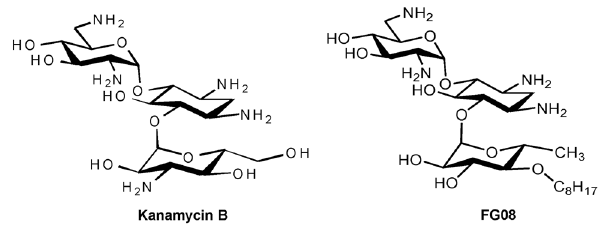
Figure 1. Structures of aminoglycosides kanamycin B and